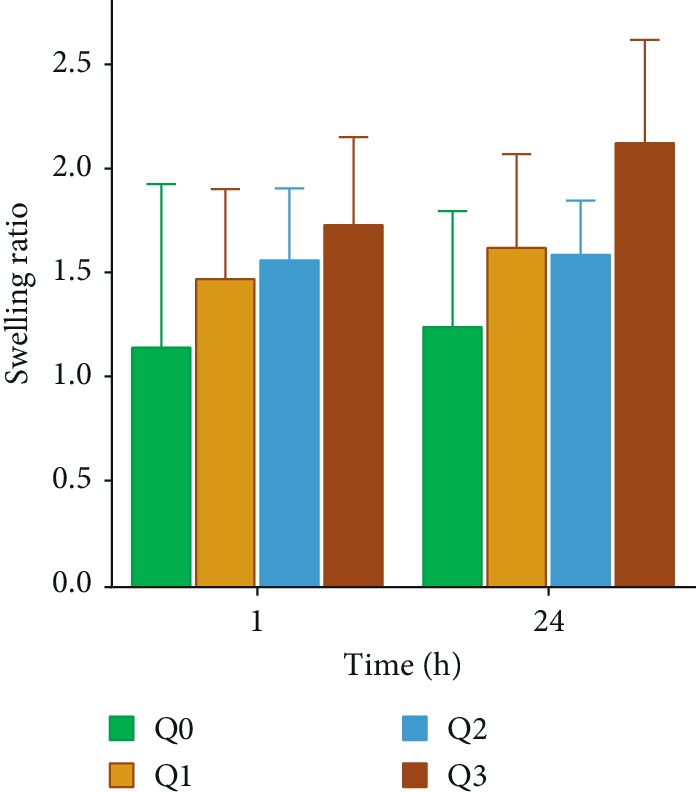
Expansion behavior of composites in PBS.